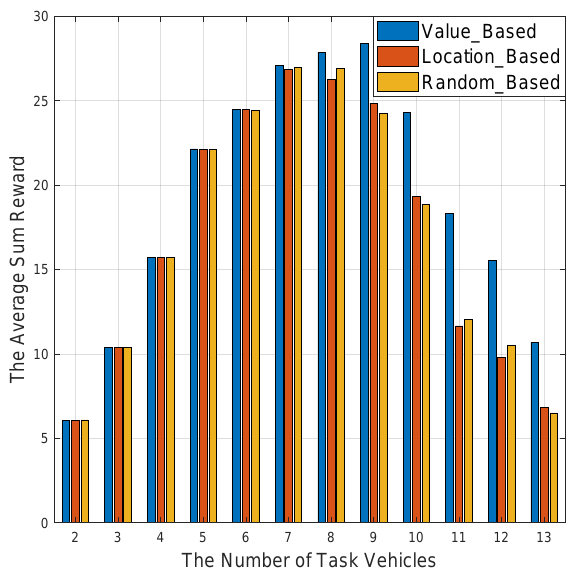
Figure 12. Performance comparisons among different iteration orders.